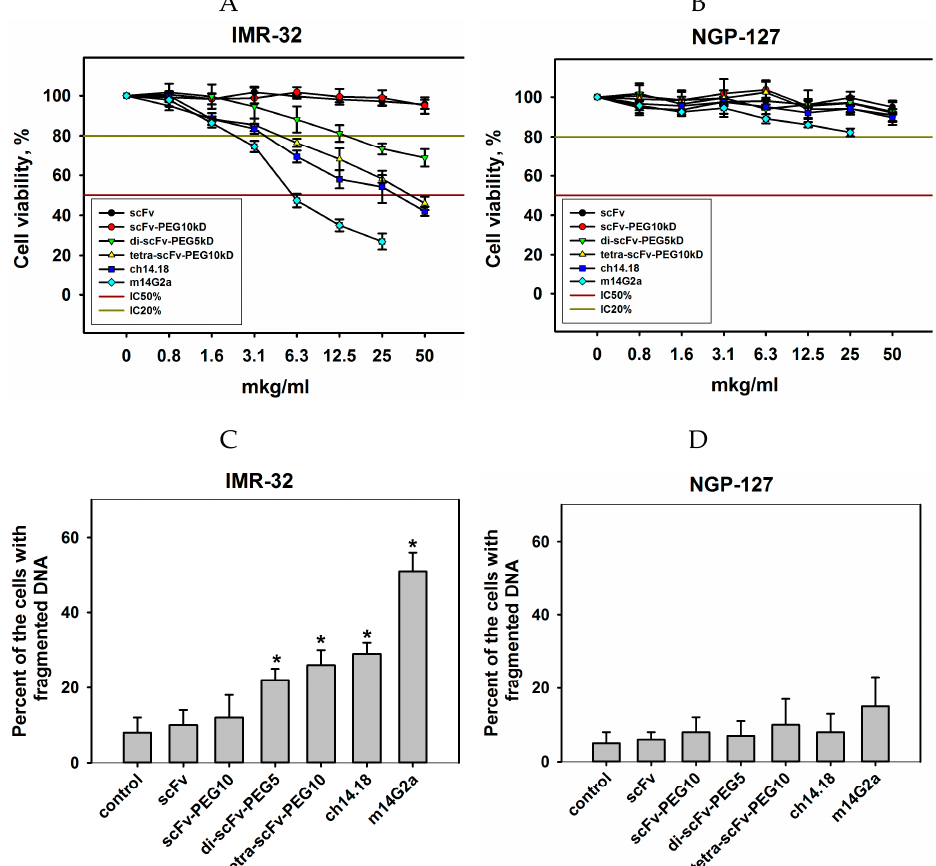
Figure 7. Direct cell death e ff ects following incubation with intact scFv fragments, pegylated monomers of scFv fragments, pegylated di- and tetra-scFv fragments, and full-length GD2-specific antibodies (chimeric 14.18 and mouse 14G2a). ( A ) GD2-positive IMR-32 cell line, 3-[[4,5]-dimethylthiazol-2- yl]-2,5-diphenyltetrazolium bromide (MTT)-assay after 72 h incubation; ( B ) GD2-negative NGP-127 cell line, MTT-assay after 72 h incubation; ( C ) IMR-32 cell line, propidium iodide (PI)-test after 24 h incubation; ( D ) NGP-127 cell line, PI-test after 24 h incubation. Control cells incubated with phosphate-bu ff ered saline (PBS). Data are represented as mean ± standard error of the mean (SEM). *—Indicates a value that significantly di ff ers from the control value at p < 0.05 (Student’s t -test, n = 5).